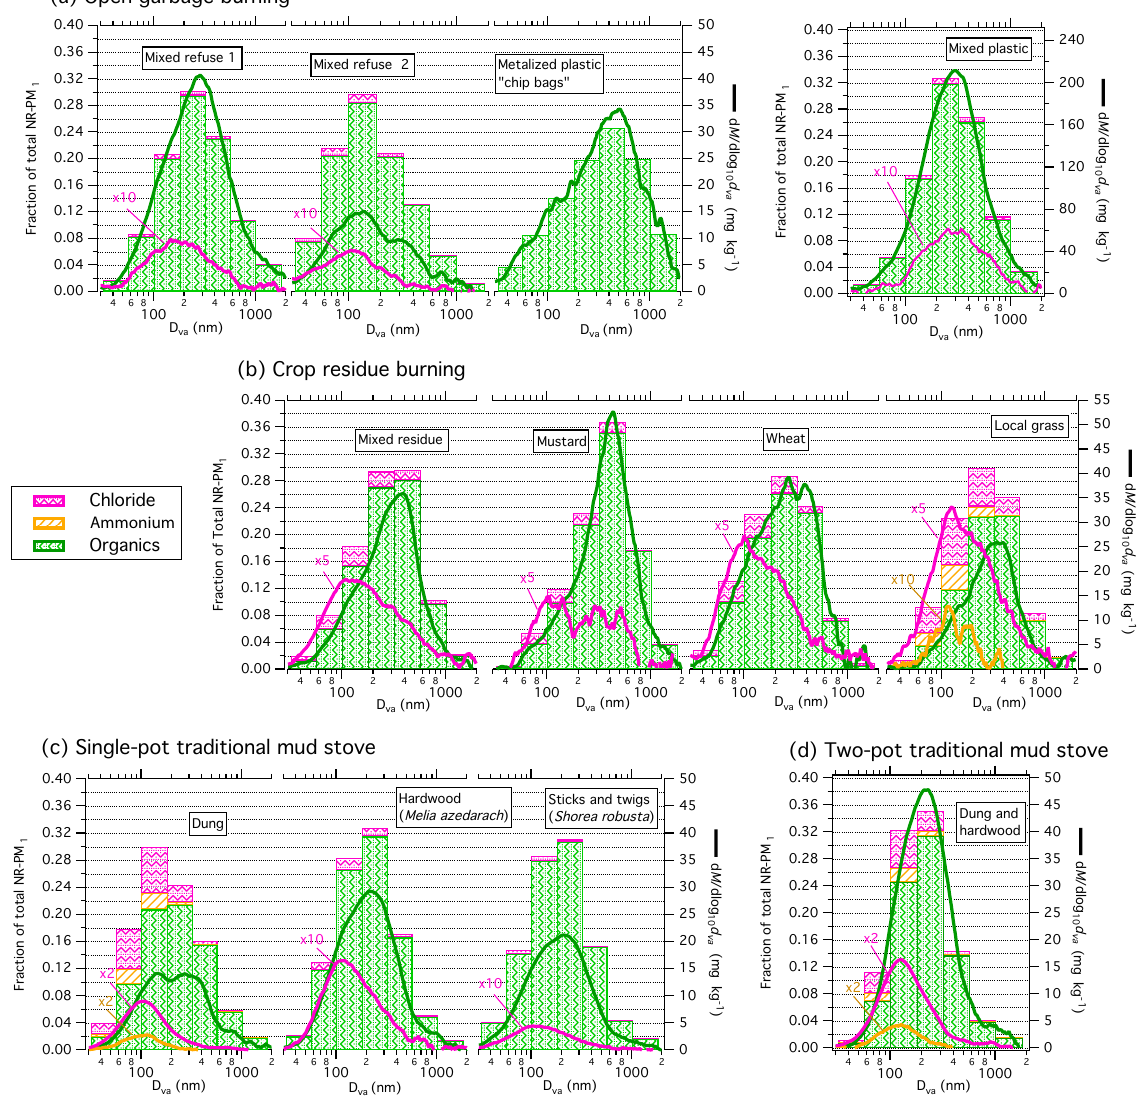
Figure 2. Size-resolved emission factors of (a) open garbage burning, (b) agricultural residue burning, and (c, d) cooking with a traditional mud stove. Continuous species-specific mass size distributions normalized by the test-integrated emission factor are shown as solid lines. Cumulative binned mass size distributions normalized by the total non-refractory submicron aerosol mass (NR-PM 1 ) are shown as stacked bars. The distribution bins are 32, 56, 100, 180, 320, 560, 1000, and 1800nm. All sizes are shown as vacuum aerodynamic diameters, d va .